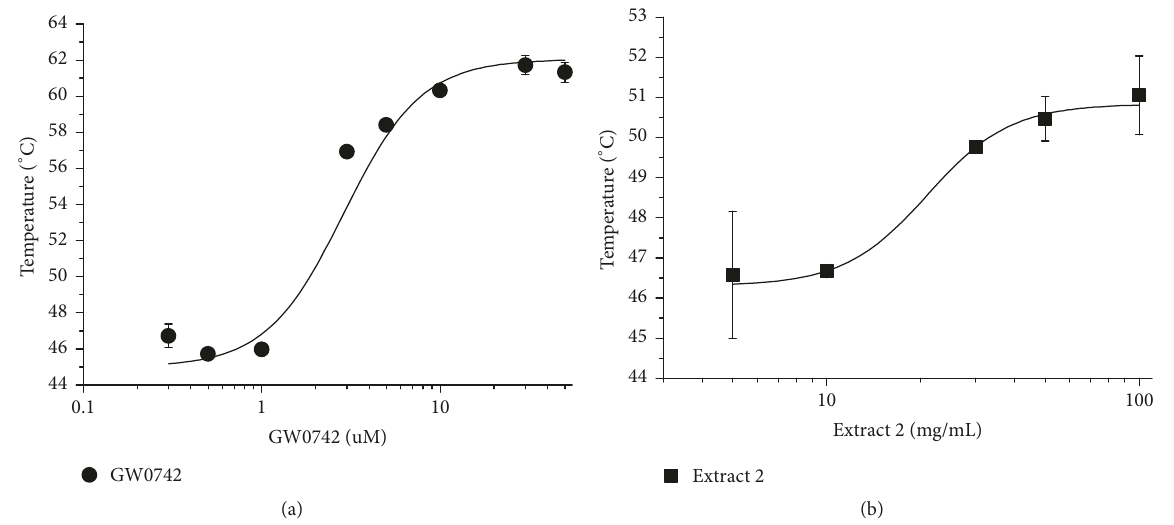
Figure 6: Quantitative TSA of PPARß/ 𝛿 in different concentrations of GW0742 (a) and extract 2 (b). The curves were made using 10 𝜇 M PPARß/ 𝛿 . The GW0742 concentrations were 0.3, 0.5, 1, 3, 5, 10, 30, and 50 𝜇 M, and the extract 2 concentrations were 5, 10, 30, 50, and 100 𝜇 g/mL (higher concentrations of the extract were discarded since they absorb in the used wavelengths). The temperature was varied from 20 ∘ C to 90 ∘ C in a ramp of 1 ∘ C/minute. The 𝑇 𝑚 variations in the entire curves were approximately 16 ∘ C for GW0742 and 5 ∘ C for extract 2. Data are the mean ± SD ( 𝑛 = 3 independent